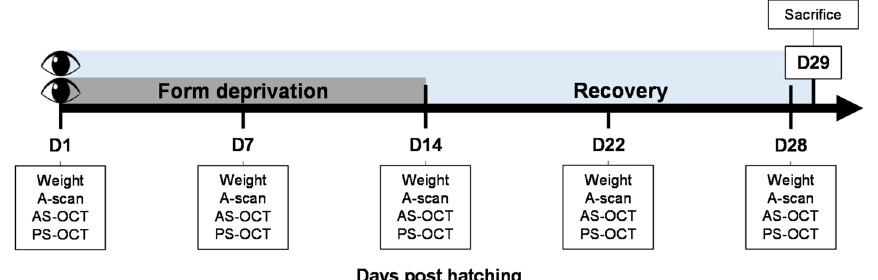
Figure 2. Experimental protocol. Thirty-six, 1-day old chicks were randomly assigned to two groups of 18 animals each and raised under SW or BEW light emitting diode (LED) lighting for 29 days. Animals were randomly monocularly fitted with a diffuser on D1. Diffusers were removed on D14 and FDEP eyes recovered until D29. Ophthalmic examinations were performed on D1, D7, D14, D22 and D28. On D29, animals were sacrificed and eyes were enucleated. The retinas and vitreous were harvested for metabolomic analysis. Ten eyes were dissected for histological evaluation of the retina, choroid and sclera. AS-OCT anterior segment optical coherence tomography, PS-OCT posterior segment optical coherence